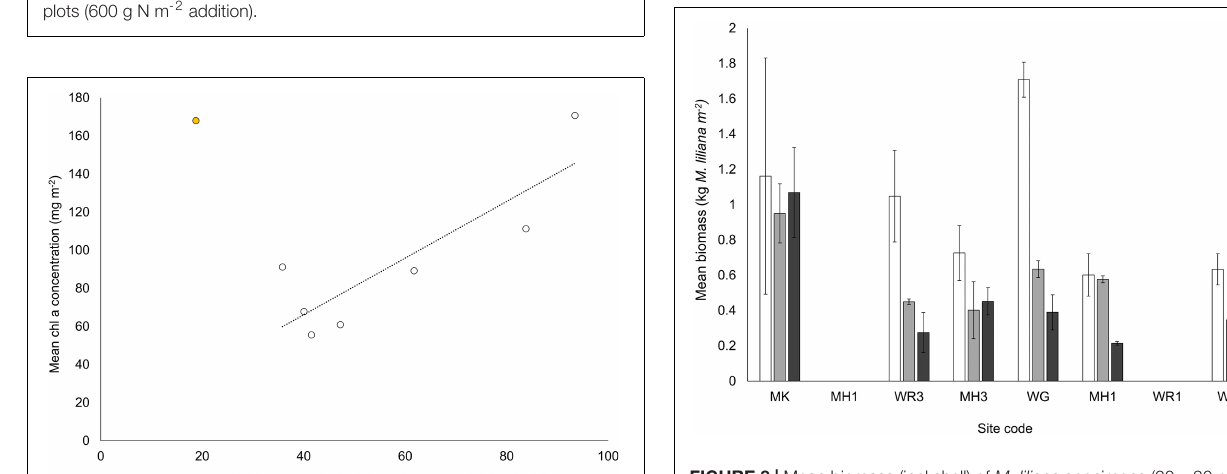
FIGURE 8 | Mean biomass (incl shell) of M. liliana specimens (20 – 30 mm length, kg dry weight bivalves m 2 , ± SE, n = 3) as a function of site and nutrient enrichment treatment. Nutrient treatments; white bars – control plots (0 g N m - 2 addition), light gray – medium plots (150 g N m - 2 addition), dark gray – high plots (600 g N m - 2